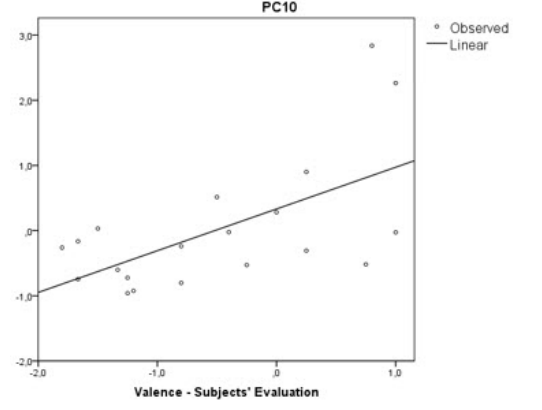
Figure 6. Interdependency between the valence-scores of the texts and their phonetic metadata.